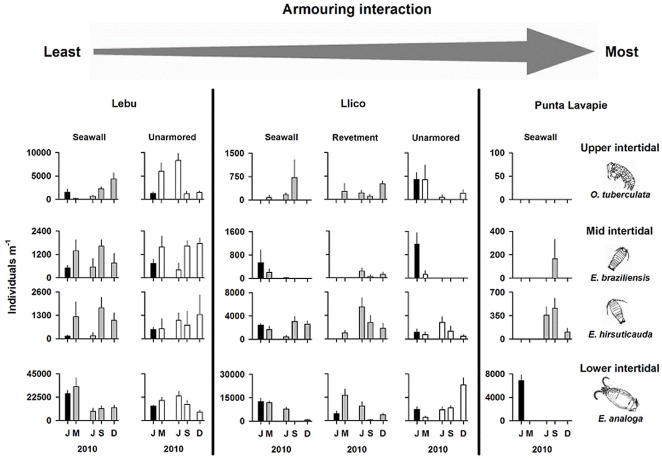
Responses of sandy beach macrofauna to uplift and coastal armouring over time.Temporal patterns in population abundance of crustaceans from the three intertidal zones listed in Fig. 3 for armoured sites that experienced different amounts of interaction between the structure and local waves and tides before the 2010 earthquake and tsunami, and for unarmoured sites. Mean values (+1 standard error) of abundance before the event are indicated by black bars, mean values of post-event abundance for armoured sites are grey bars and unarmoured sites are white bars. Strength of pre-event armouring and wave interaction (see Methods) increases from left to right as indicated by the grey arrow at the top of the figure. Data are presented as individuals m−1 to accommodate changes in beach widths; trends for individuals m−2 were similar.